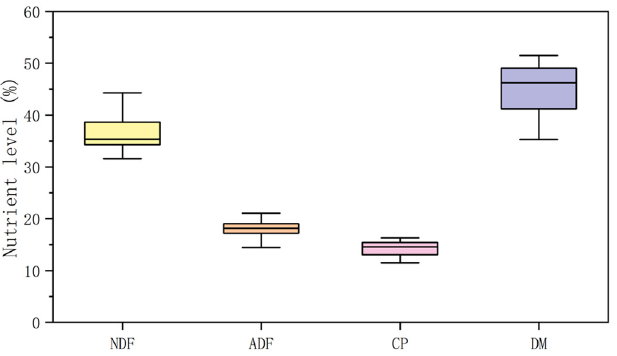
Figure 1. Boxplot of the nutrient levels (neutral detergent fiber (NDF), acid detergent fiber (ADF), crude protein (CP), and dry matter (DM)) in the dataset.